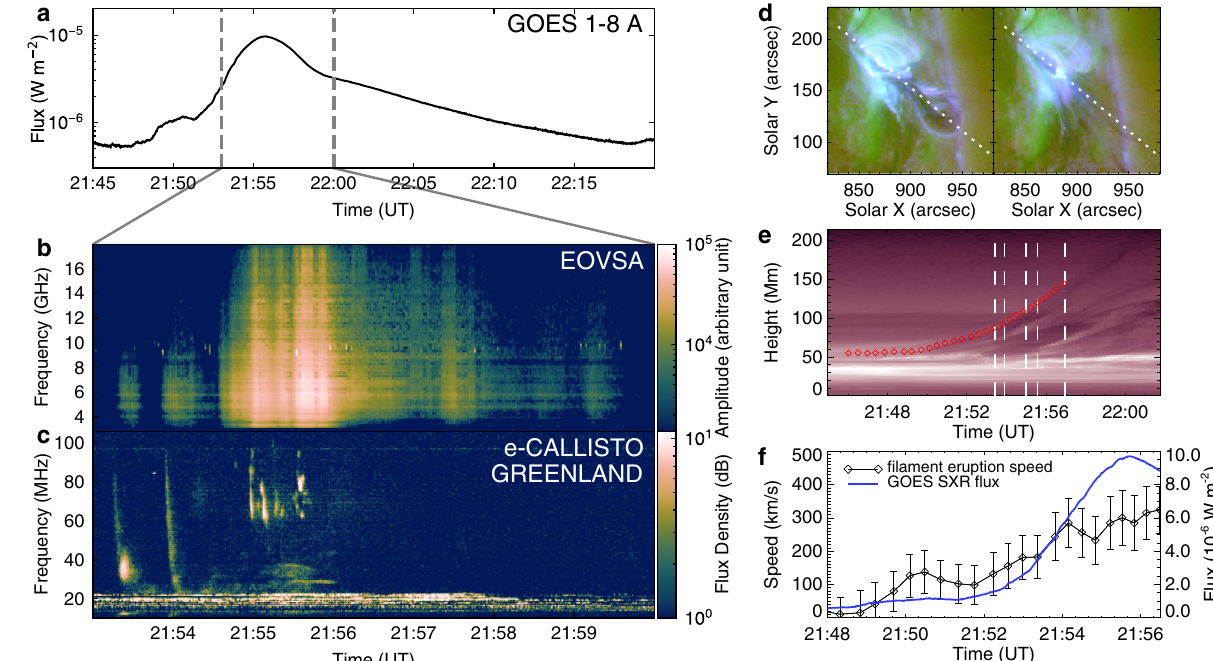
Fig. 1 | Overview of the fl are event. a GOES SXR 1 – 8Å fl ux curve of the fl are. b , c EOVSA cross-power and e-CALLISTO/GREENLAND DS during 21:53 – 22:00UT. d SDO/AIAcompositeimagesof131(blue),171(red)and211Å(green)at21:54:58UT and 22:09:22 UT. The white dotted lines represent slits along the direction of the fi lament eruption. e AIA 211Å slice-time plot showing the evolution of the fi lament